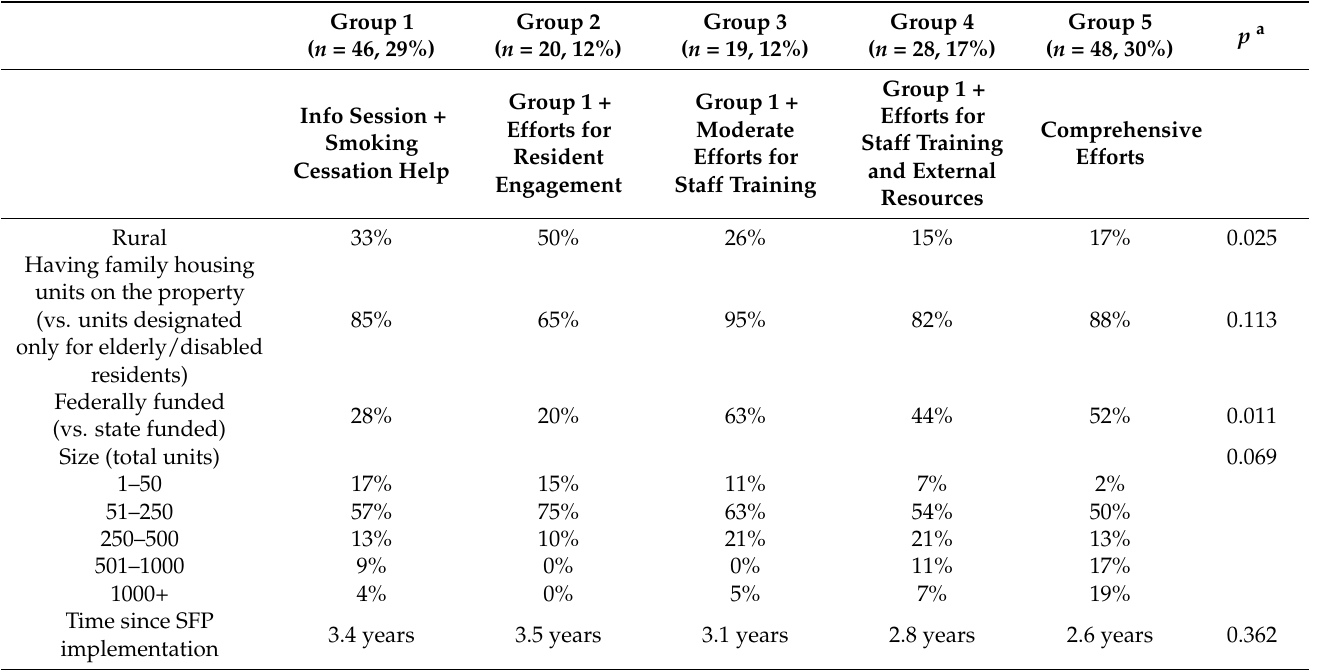
Table 3. Characteristics of the five PHA groups as defined by their types of implementation activities ( n =